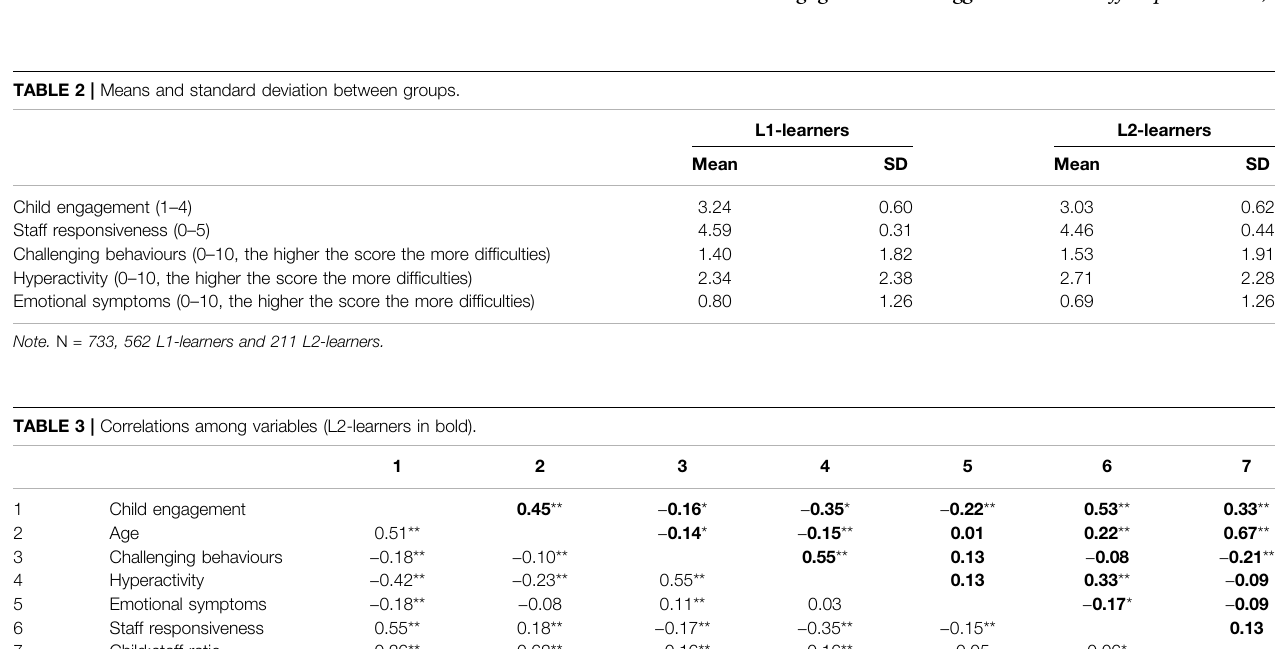
Initially, we tested the suggested models in a path analysis. The suggested models showed poor fi t indices (see Table 4 — Suggested model child engagement and Suggested model staff responsiveness ).